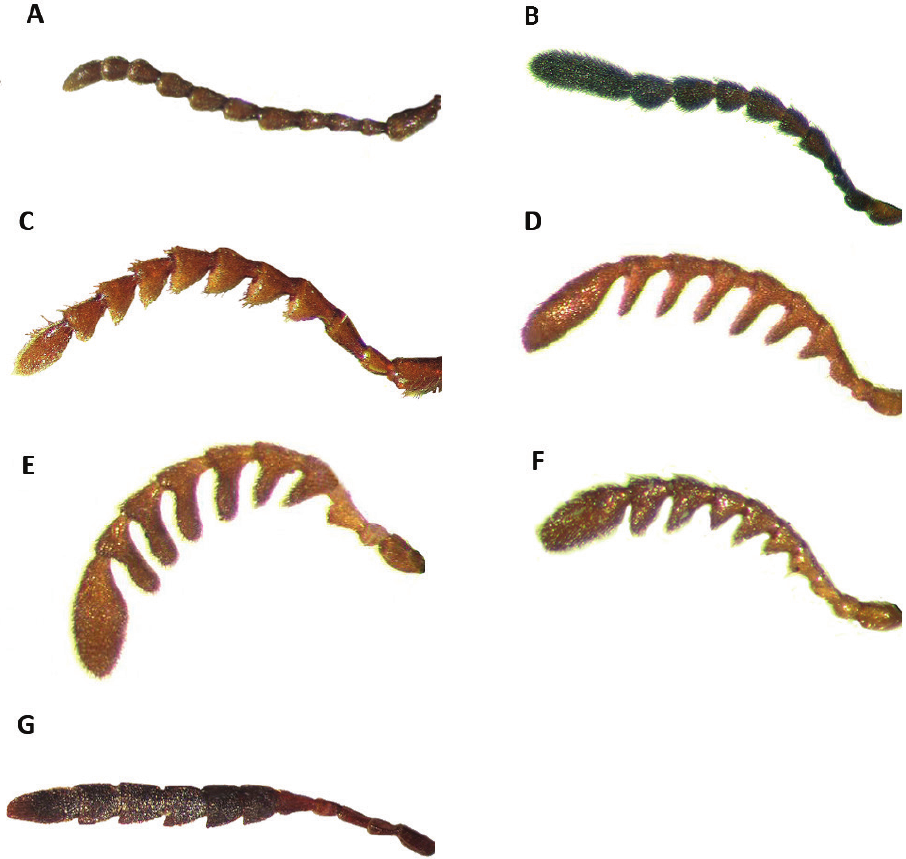
Figure 8. Antennae of: A Araeodontia peninsularis (male) B Barrotillus kropotkini (male) C Bogcia oaxa- cae (male) D Neocallotillus elegans ( elegans ) (male) E Neocallotillus elegans ( vafer ) (male) F Neocallotillus elegans ( elegans ) (female) G Cylidrus abdominalis (male). arranged in regular striae that gradually become smaller toward apex, striae reaching elytral apex; interstices at elytral base about 2.5× the width of punctuation. Abdomen: Six visible ventrites. First visible ventrite medially elevated; lateral portions feeble excavated; ventrites 1–4 slightly rugose, subquadrate, shallowly punc- tate; vested with long, fine, pale, recumbent setae. Fifth visible ventrite subquadrate; surface convex, coarsely punctate; lateral margins subparallel; posterior margin trun- cate. Sixth visible ventrite subquadrate; broader than long; surface rugulose; mod- erately, coarsely punctate; lateral margins conspicuously oblique; posterior margin broadly rounded, producing a semicircular margin. Fifth tergite rugulose; lateral margins subparallel; posterior margin truncate, with a narrow, shallow, subtriangular emargination. Sixth tergite subtriangular; broader than long; surface rugulose; lateral margins feebly arcuate, oblique; posterior margin short, rounded; lateral and